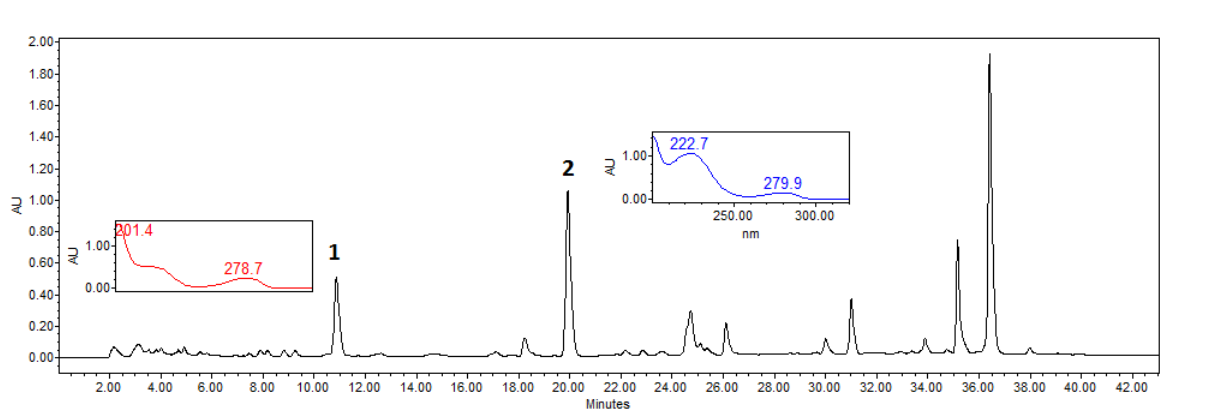
Fig. 6. The chromatogram of traditional herbal medicine